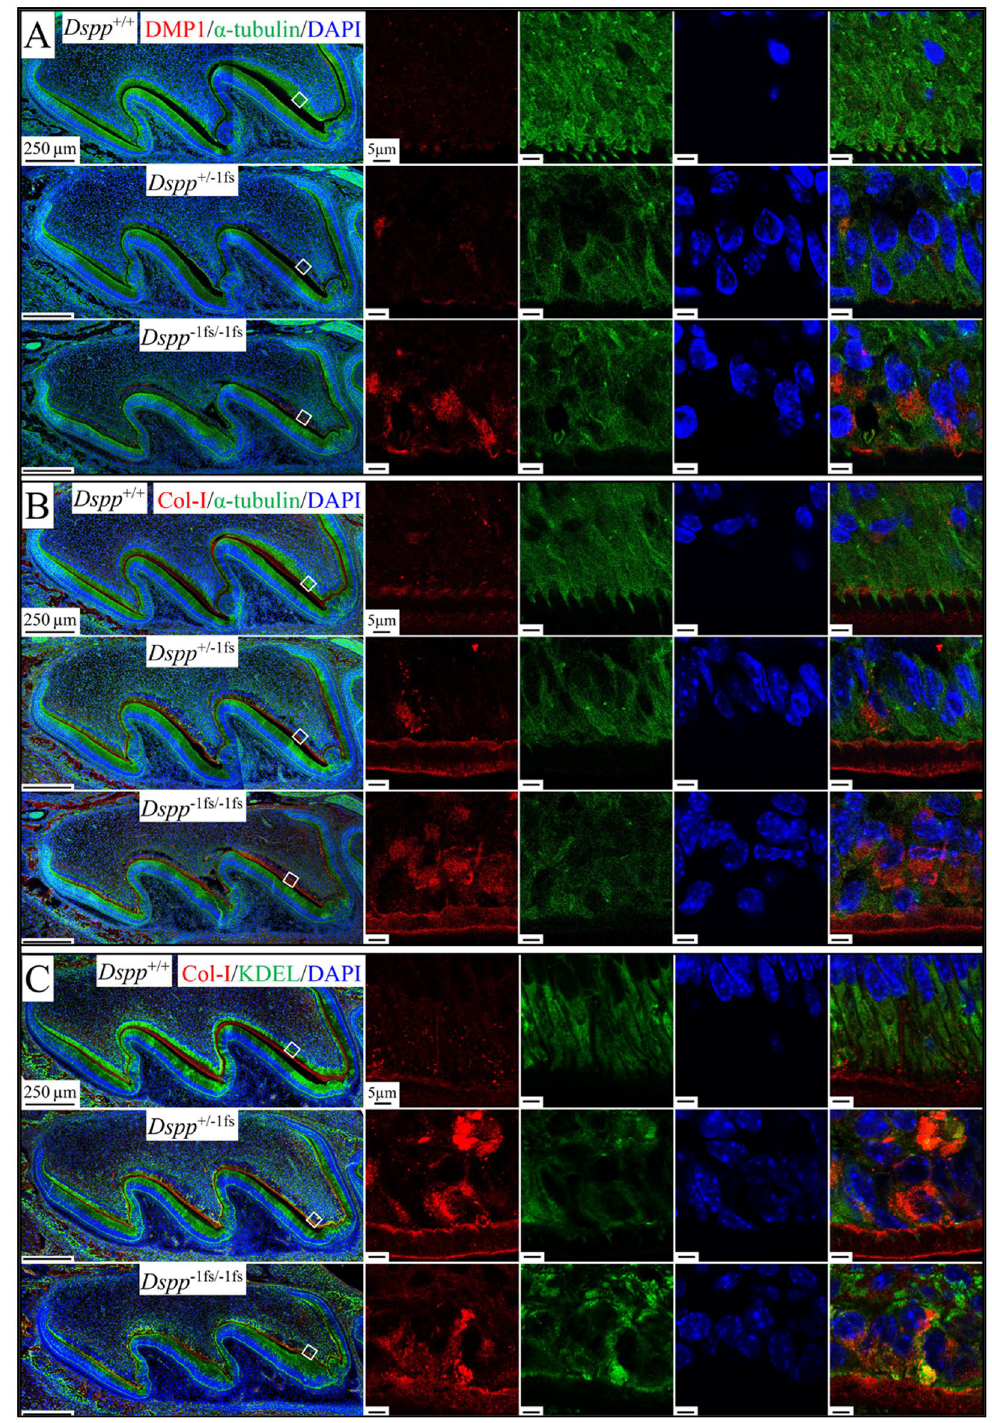
Figure 6. Intracellular retention of DMP1 and type I collagen in the odontoblasts of Dspp −1fs mice. Immunohistochemistry on D3 maxillary 1st molars, showing DMP1 (red in A) or type I collagen (red in B&C), α-tubulin (green in A&B; boundary of cells) or KDEL (green in C; ER), and DAPI (blue; nucleus). ( A ) In Dspp +/+ odontoblasts, intracellular DMP1 is weakly detected at distal end of odontoblast cell bodies. In Dspp -1fs odontoblasts, intracellular DMP1 signals are upregulated. ( B ) In Dspp +/+ , type I collagen is most prominent in dentin matrix. In Dspp −1fs , type I collagen is evident in dentin matrix and within odontoblasts. ( C ) In Dspp +/+ odontoblasts, most type I collagen locate outside of ER. In Dspp −1fs odontoblasts, most intracellular type I collagen signals overlap with KDEL signals. Scale bars: 250 μm (left)/5 μm